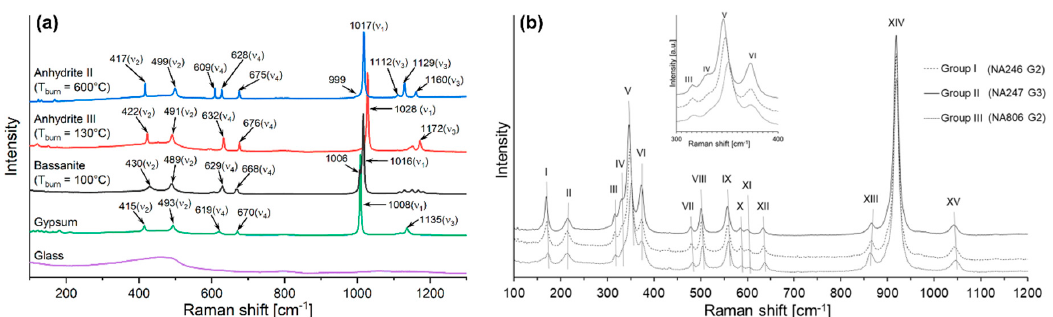
Figure 4. ( a ) Raman spectra of four phases of the CaSO 4 –H 2 O system, and ( b ) spectra of almandine garnets representative for three groups (figures adapted from [7,10]; see references for details).